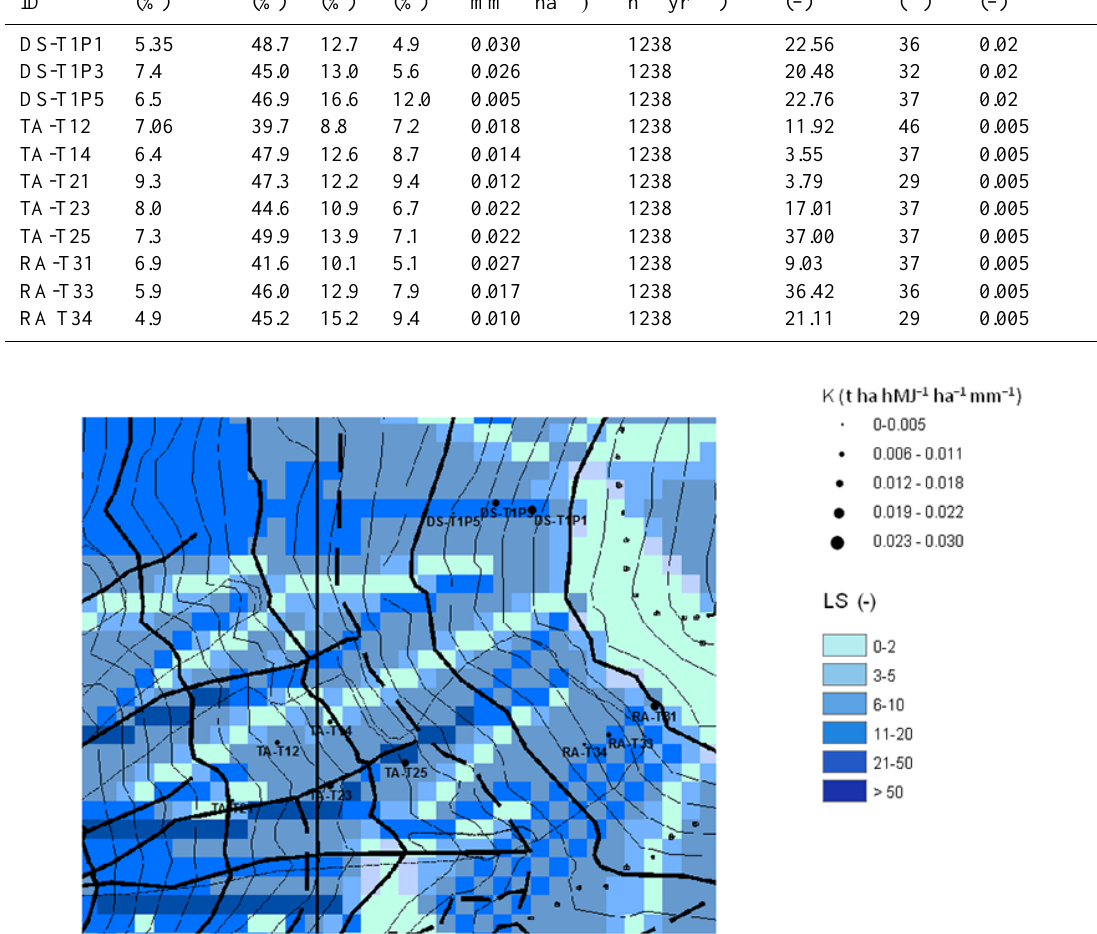
Figure 3. RUSLE LS factor map plotted on a 1 : 10000 topographic map. The sampling point size is proportional to the RUSLE soil erodibility factor ( K ). The blue-colored grid represents the LS factor. DS: defense structures area; TA: track area; RA: release